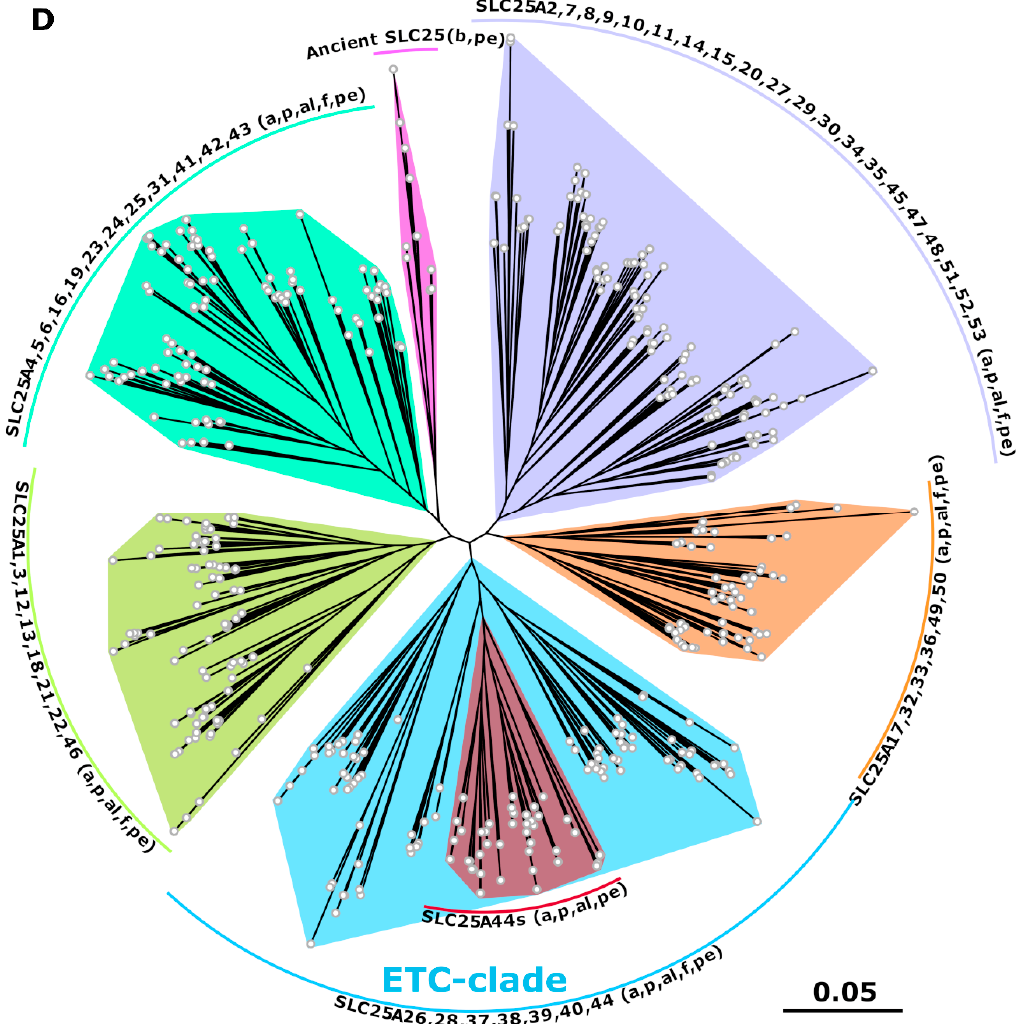
Figure 3. Identification of SLC25A44 as a candidate transporter for the common precursors of ubiquinone and resveratrol. ( A ) The co-localization of membrane transporter genes with their co-expressed and co-interacting partner genes within the genomic window size of ±10 genes. ( B ) The identified genomic block in peanut. The metabolic relation among the genes is shown. ( C ) Metabolic pathway enrichment for the genes co-expressed with Slc 25A44. ( D ) The phylogenetic tree of mitochondrial carriers. The tree includes SLC25 members from four primitive eukaryotes, four fungal species, two animals, one plant and one algal species, ancient SLC25 members from five bacterial species, and finally members of SLC25A44 from additional 18 animals and seven plant and algal species. See Tables 1 and S5 for the species names and accession number of sequences. The clades are labeled by letters “a” for animal, “p” for plant, “f” for fungi, “pe” for primitive eukaryotes, and “b” for bacteria when there is at least one representative transporter member from the corresponding domains of life. CHS: chalcone synthase, ETC: electron transfer chains, FC: fold change in co-localization likelihood,